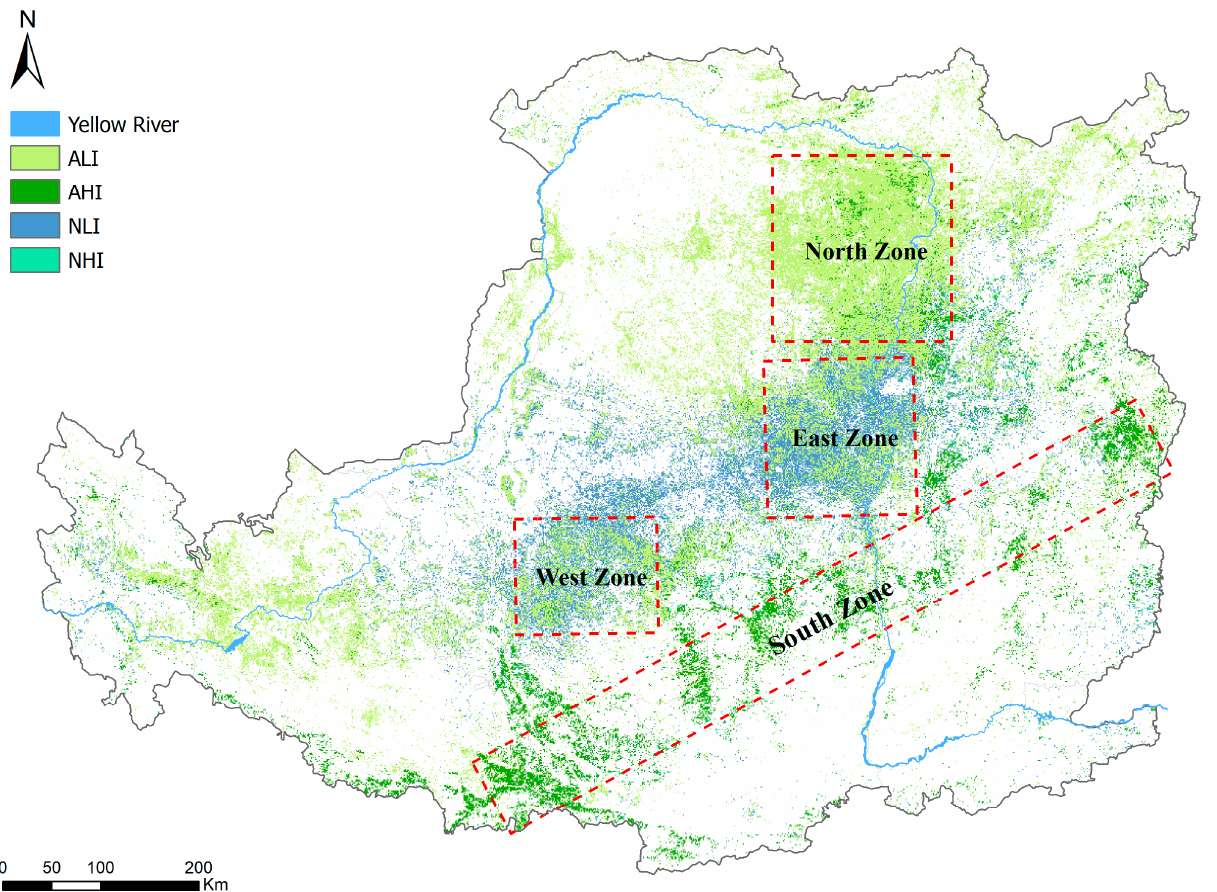
Figure 2. Divergence of artificial and natural significant tree cover increase in Loess Plateau with trend slope larger than 1 (high increase) and smaller than 1 (limited increase) and representative zones including North Zone (NZ), East Zone (EZ), South Zone (SZ) and West Zone (WZ). ALI: Artificial forest with limited tree cover increase, AHI: Artificial forest with high tree cover increase, NLI: natural forest with limited tree cover increase, NHI: Natural forest with high tree cover increase. Table 1. Areas (km 2 ) for VCF tree cover increase and decrease in artificial forest and natural forest. Area with Tree Cover Increase (km 2 )